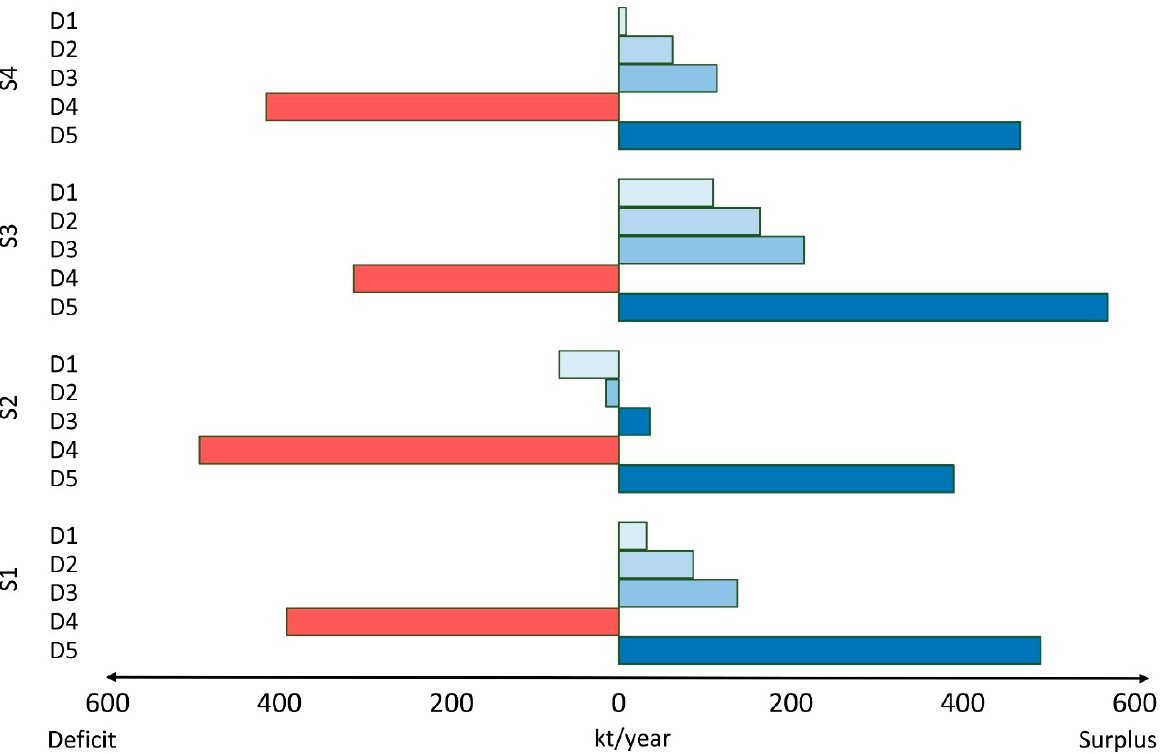
Figure 4. Difference (kt/year) between the levels of Thai seafood availability and consumption scenarios in 2030. D1: Maintaining current seafood consumption (32 g/day), D2: Healthy and balanced seafood consumption (30 g/day), D3: Healthy diets from sustainable food systems (28 g/day), D4: Higher consumption (48 g/day), and D5: Lower consumption (14 g/day). S1: Maintaining current seafood availability, S2: Decreasing capture fisheries (13% of reduction of yield of capture production in 2015), S3: Expansion of aquaculture production (1% of increase of yield of aquaculture), and S4: Combination of S2 and S3. Blue bars represent the surplus of Thai seafood availability and consumption in 2030 while red bars represent the deficit of Thai seafood availability and consumption in